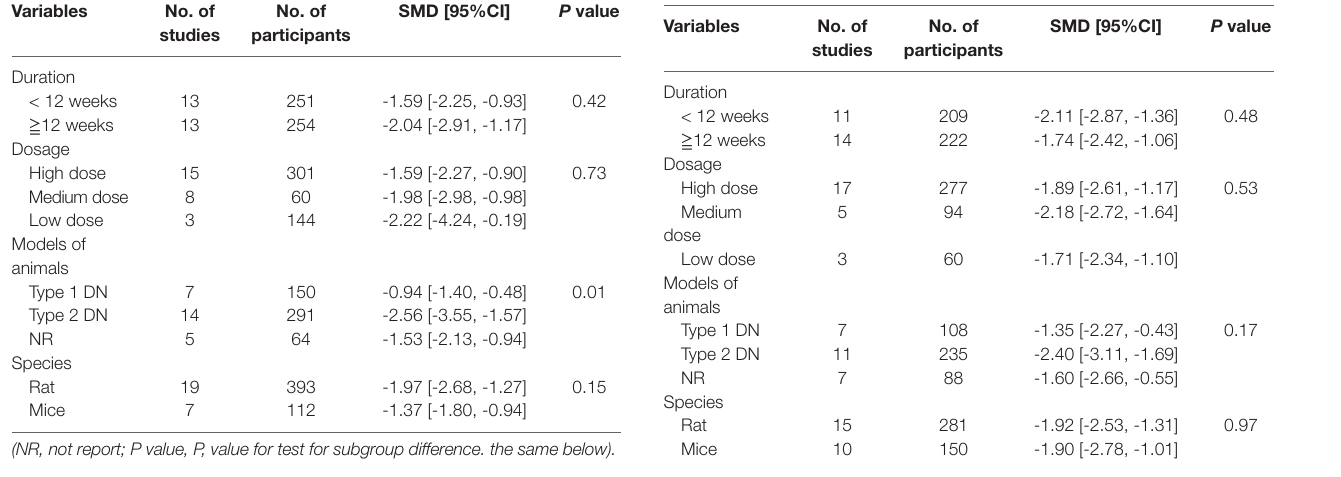
tABLe 3 | Subgroup analysis according to blood glucose.